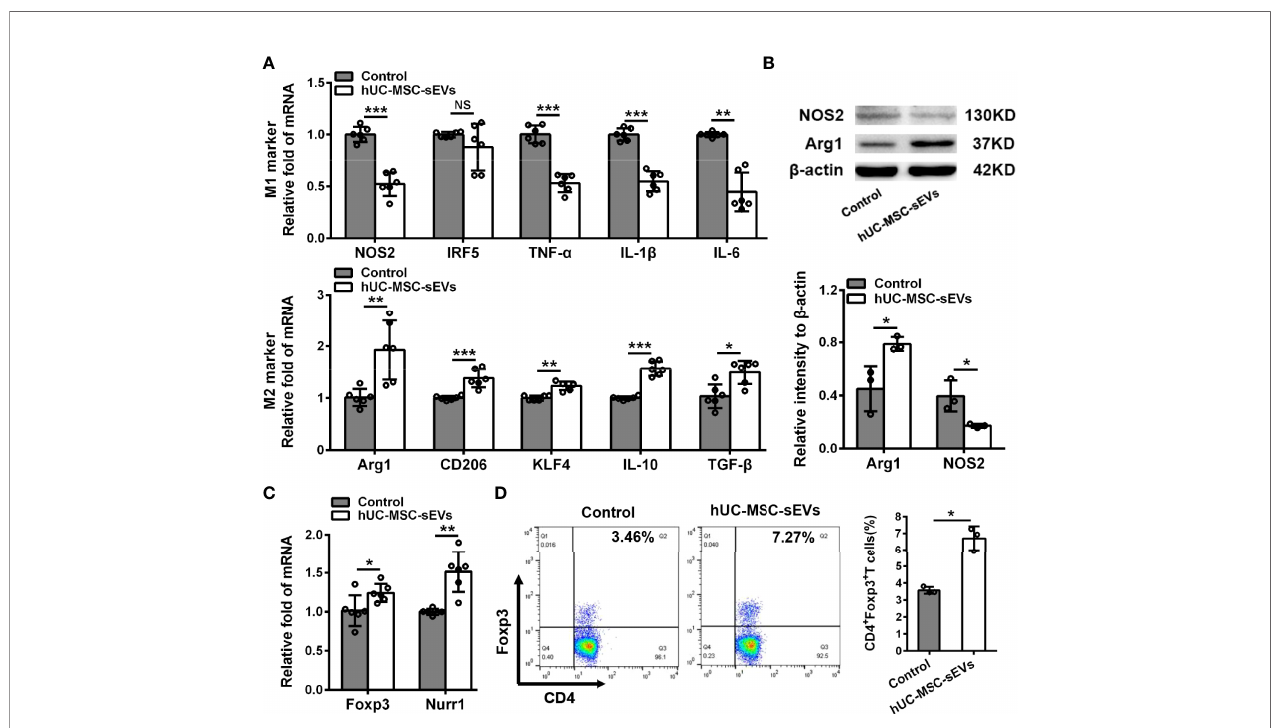
FIGURE 5 | hUC-MSC-sEVs regulated M2 macrophage polarization and Treg differentiation in vitro . PBMCs isolated from model rabbits were stimulated with irradiated pLGECs, and then were treated with or without hUC-MSC-sEVs (5 m g/ml). (A) Gene expression pro fi les of M1 markers (NOS2, IRF5, TNF- a , IL-1 b and IL-6) and M2 markers (Arg1, CD206, KLF4, IL-10 and TGF- b ) in PBMCs. (B) Western blot analysis of NOS2 and Arg1 protein level in PBMCs. (C) The mRNA expression of Foxp3 and Nurr1 in PBMCs. (D) Representative fl ow cytometry showing the frequency of CD4+Foxp3+ T cells in PBMCs. Data were from at least three independent experiments and presented as mean± SD. *P < 0.05, **P < 0.01, ***P < 0.001, NS, not signi fi